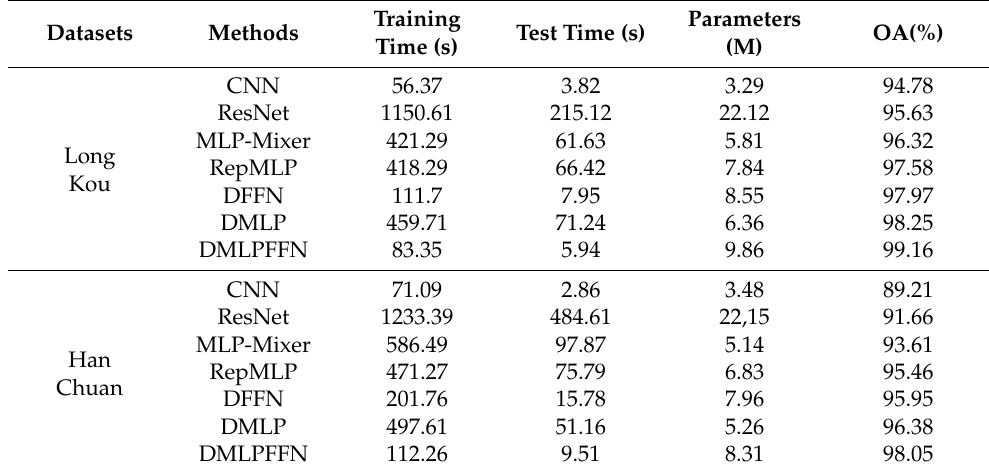
Table 11. Comparison of time consumption and computational complexity of different classifica- tion